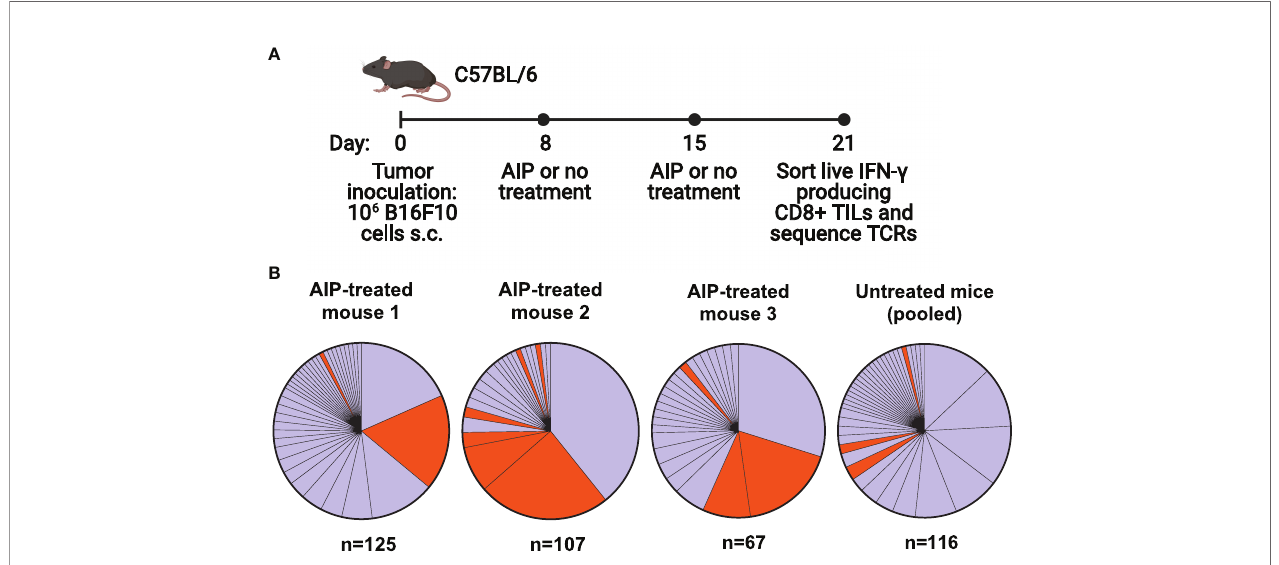
FIGURE 1 | The T cell response following combination immunotherapy of melanoma is oligoclonal and contains a set of homologous T cell clones. (A) Timeline of B16F10 tumor inoculation, therapy for treated and untreated groups, and cell sorting (n=5 mice/group, s.c. = subcutaneous, TILs = tumor in fi ltrating T cells, TCRs = T cell receptors). (B) Clonality of T cell responses in individual treated mice and pooled untreated mice. T cells with identical alpha and beta chain sequences were identi fi ed as members of a clone. N indicates the number of T cells for which paired TCR sequences were obtained. Orange colored clones appear in Table 1